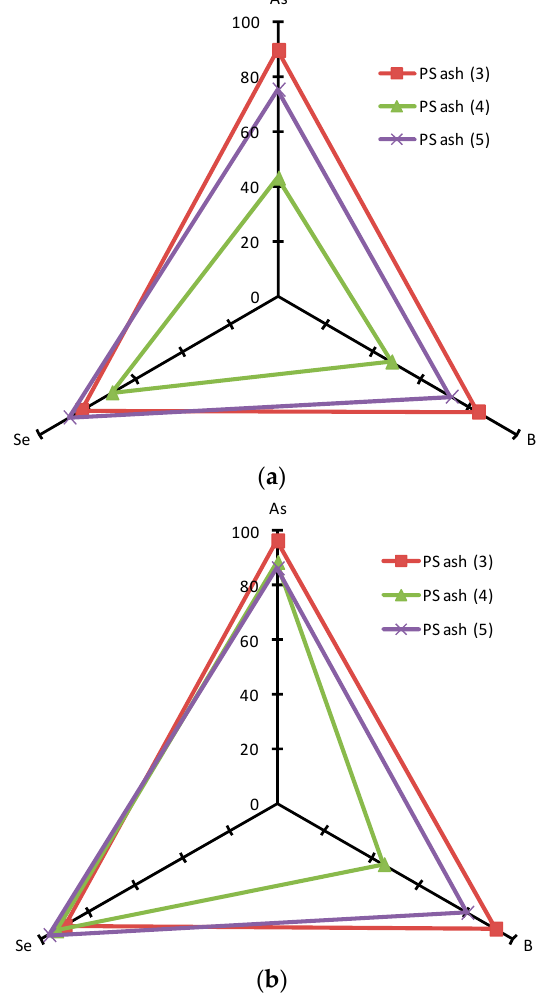
Figure 12. Trace elements (arsenic, boron, and selenium) leaching inhibition rate for ( a ) 5% Ca content; and ( b ) 10% Ca content samples.